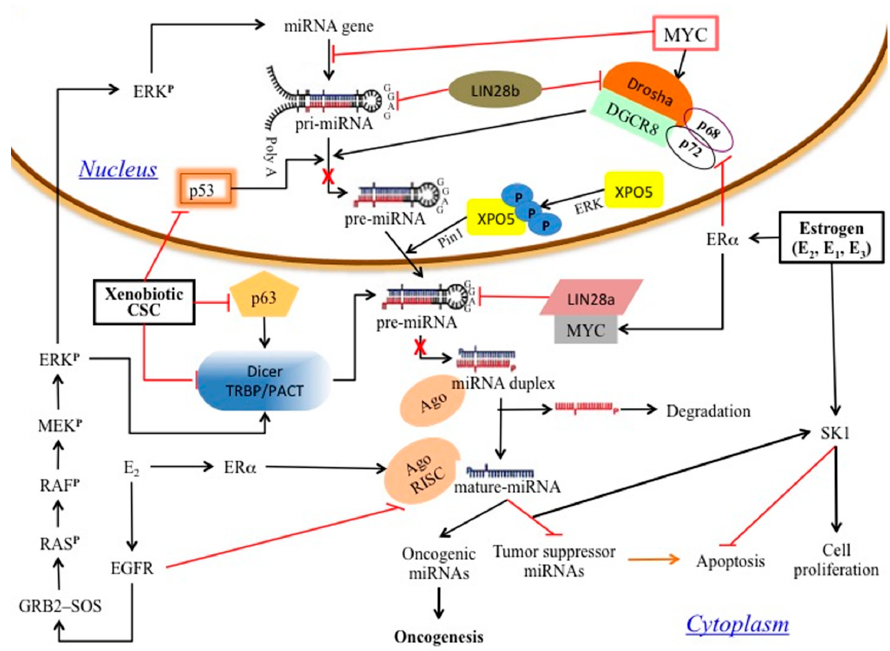
Figure 3. A model summarizing the findings revealed during this study and the potential disruption of miRNA processing events (denoted by the red crosses), leading to carcinogenesis. Arrows represent activation and blocked arrows indicate repression. CSC: cigarette-smoke condensate; EGFR: EGF receptor; ER: estrogen receptor; ERK: extracellular signal-regulated kinase; GRB: growth factor receptor-bound protein; SOS: Son of Sevenless; SK1: Sphingosine kinase 1; XPO5: Exportin-5. Since cellular RNA is under constant attack by various environmental agents that damage the molecule, elucidating the association between exposure to xenostrogens and miRNA-adducts formation may also help gain a better understanding of the health implications of these endocrine disrupting chemicals for both humans and wildlife [50,51].